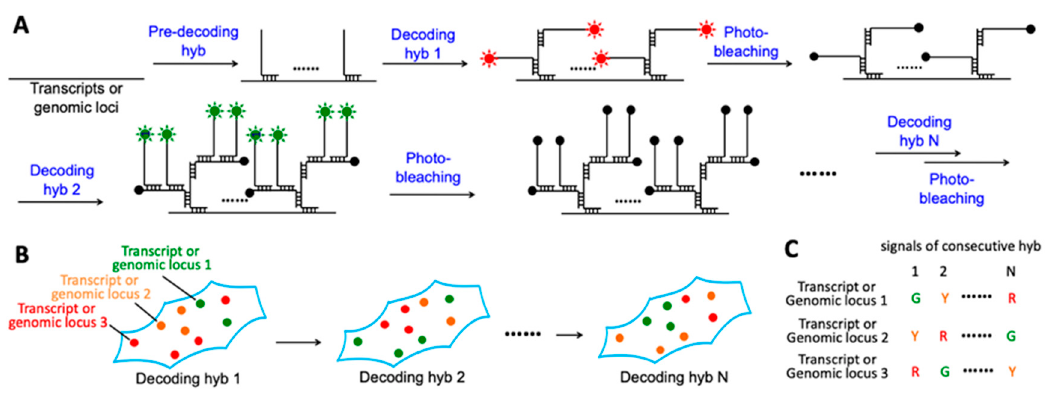
Figure 1. C-FISH: a novel method for spatial transcriptomics and genomics analysis. ( A ) Each C-FISH cycle is composed of three major steps, including probe hybridization, fluorescence imaging and photobleaching. The red and green sun-like symbols represent excited fluorophores, and the black solid dots represent photobleached fluorophores. ( B ) Under a microscope, every nucleic acid molecule is visualized as a fluorescent spot in each analysis cycle. ( C ) With their locations remaining throughout all the cycles, the identities of different nucleic acids can be determined by their corresponding color sequences.